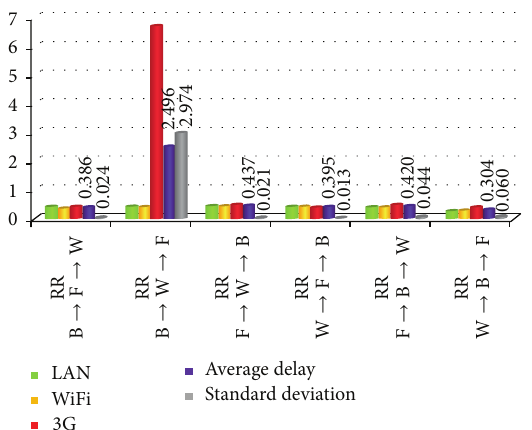
Figure 11: The result of different packet broadcasting sequences.